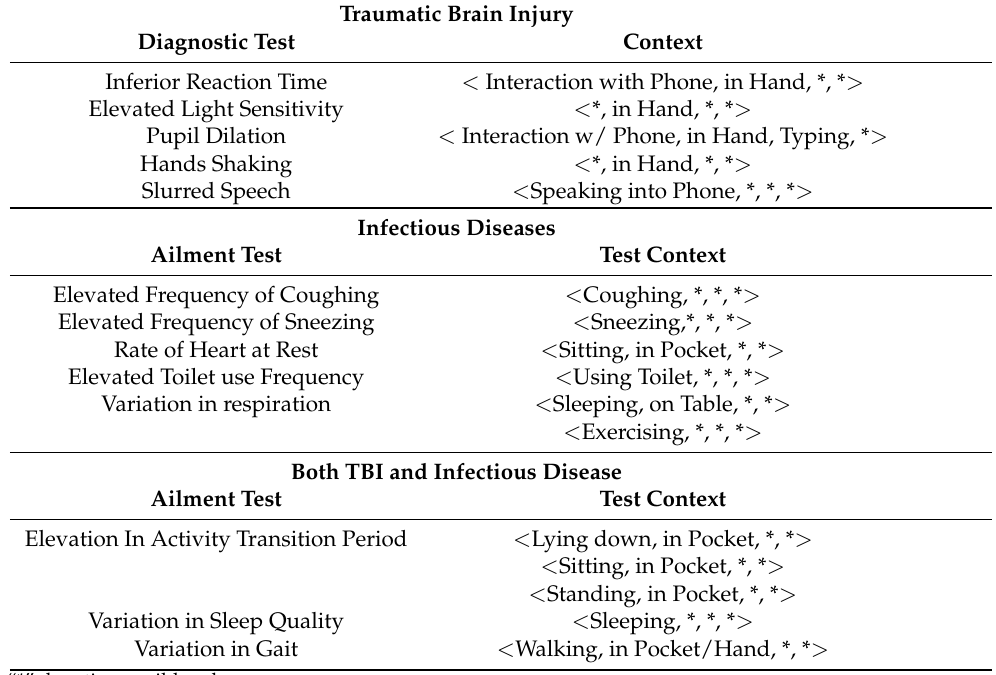
Table 1. Context-specific diagnostic tests for traumatic brain injury (TBI) and infectious diseases with their relevant human